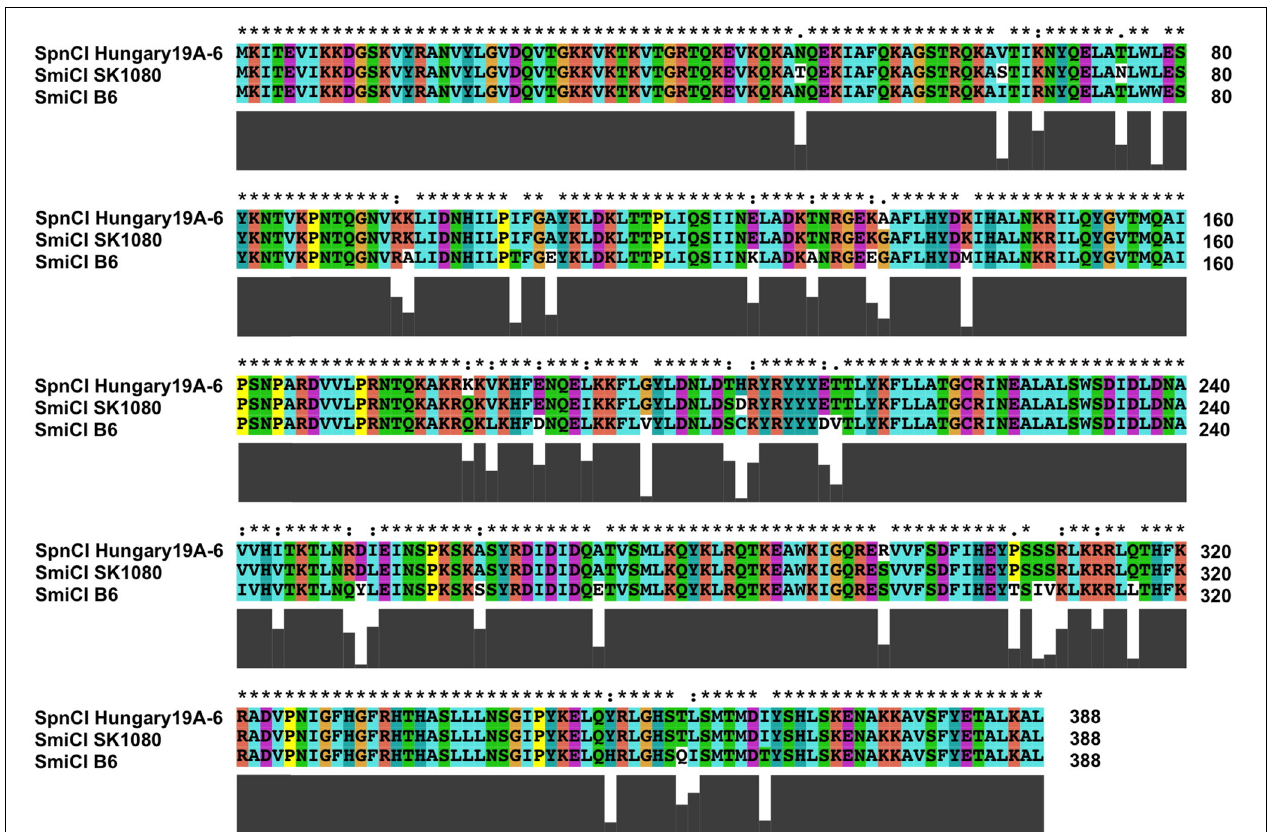
FIGURE 7 | Alignment of the SmiCI and SpnCI integrases that target either manA or uvrA . The integrase proteins encoded by the S. mitis SmiCI B6, the S. mitis SmiCI SK1080, and S. pneumoniae Hungary19A-6 SpnCI were aligned using ClustalX (Jeanmougin et al., 1998). The integrases from SpnCI Hungary19A-6 and SmiCI SK1080 both recognize an identical